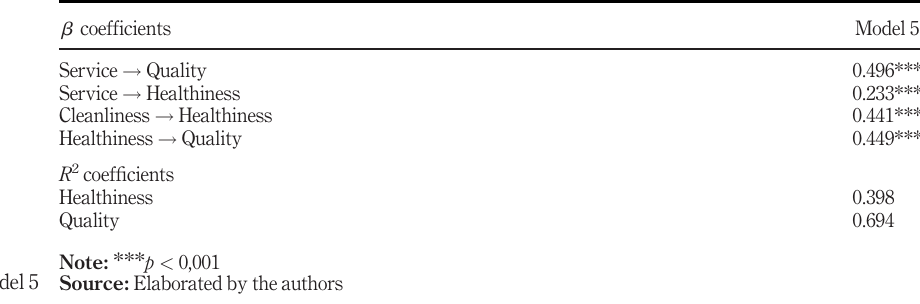
Table VII. Regression